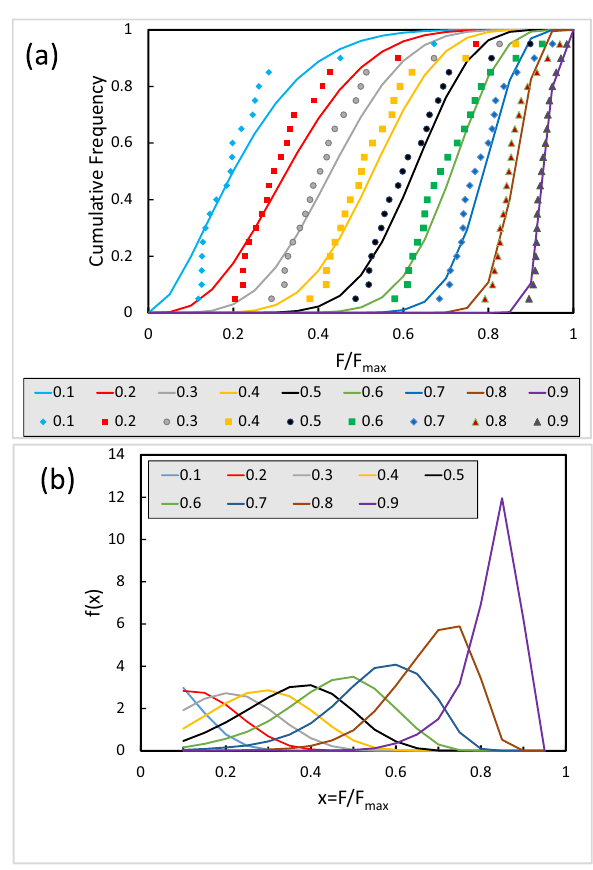
Fig. 10 a Fitting beta distribution to dimensionless cumulative infil- tration ( F / F max ) at t / t max = 0.1, 0.2, 0.3,…, 0.9, respectively. Lines are theoretical beta distribution and dots are the empirical distribution of the data, and b pdf of beta distribution at t / t max = 0.1, 0.2, 0.3 …, 0.9, water table near the ground’s surface, the waterfront stopped to advance down when touching the water table (Angelaki et al. 2021; Niyazi et al. 2022).